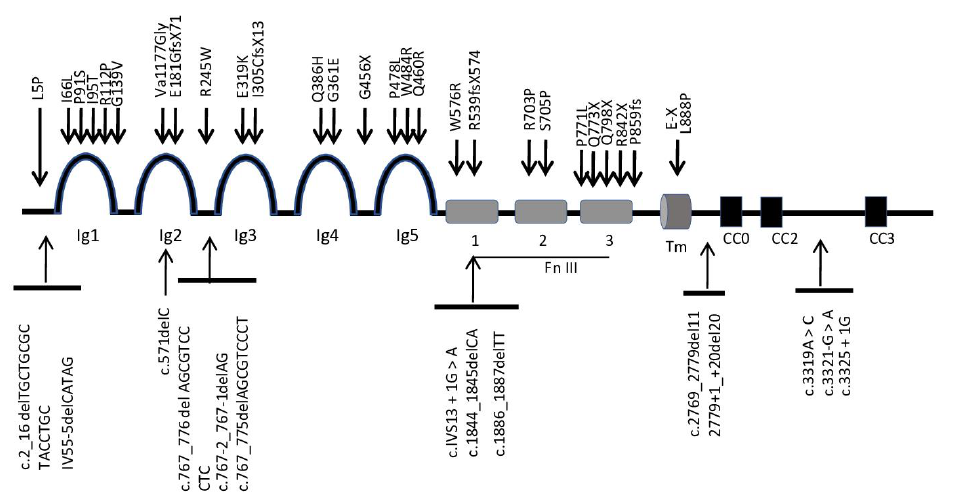
Figure 2. Roundabout ( ROBO 3) physical map domain with location of different mutations in patients with horizontal gaze palsy with progressive scoliosis (HGPPS).